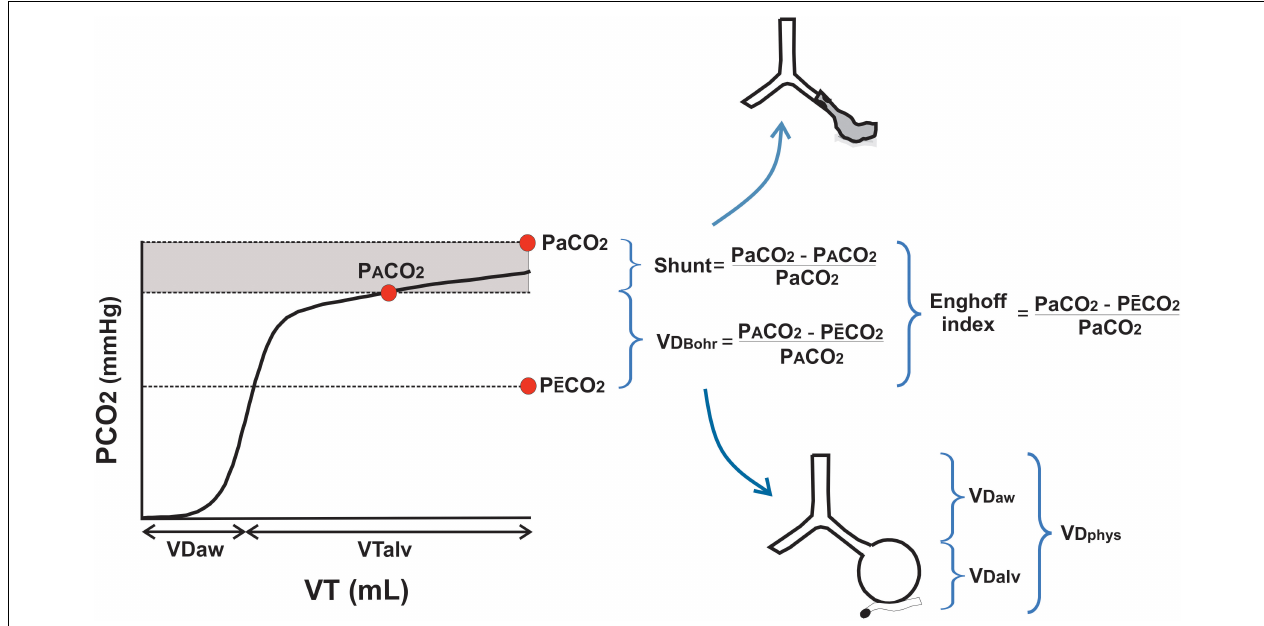
FIGURE 2 | Differences between Bohr’s and Enghoff’s approaches. The main physiological difference between Bohr’s dead space (VD Bohr ) and Enghoff’s index is visualized in one volumetric capnogram. While VD Bohr represents true dead space in non-perfused alveoli and main conducted airways, the Enghoff’s index includes also the effect of shunt and low V/Q in its calculation (gray area). PaCO 2 , PACO 2 , and PECO 2 are the arterial, alveolar, and mixed expired partial pressure of carbon dioxide, respectively. VD phys , VD aw , and VD alv are physiological, airway, and alveolar dead spaces, respectively. VT is the tidal volume and VT alv is the alveolar tidal